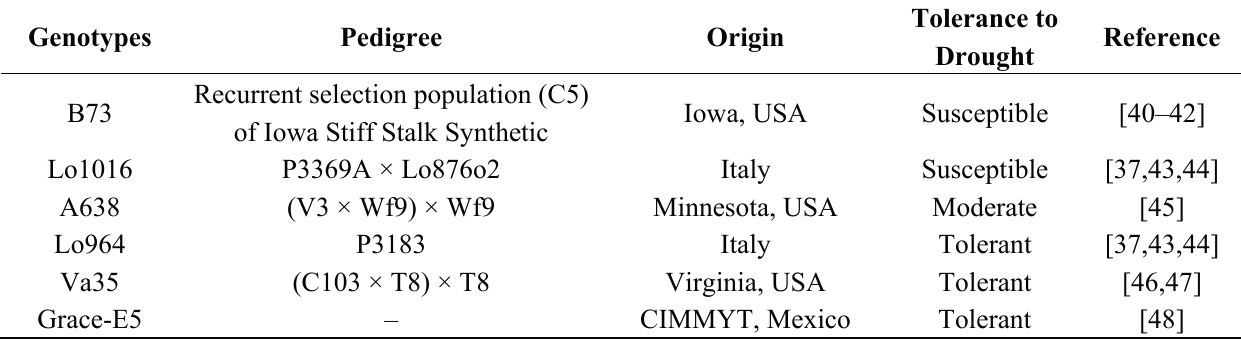
Table 1. Maize genotypes selected in this